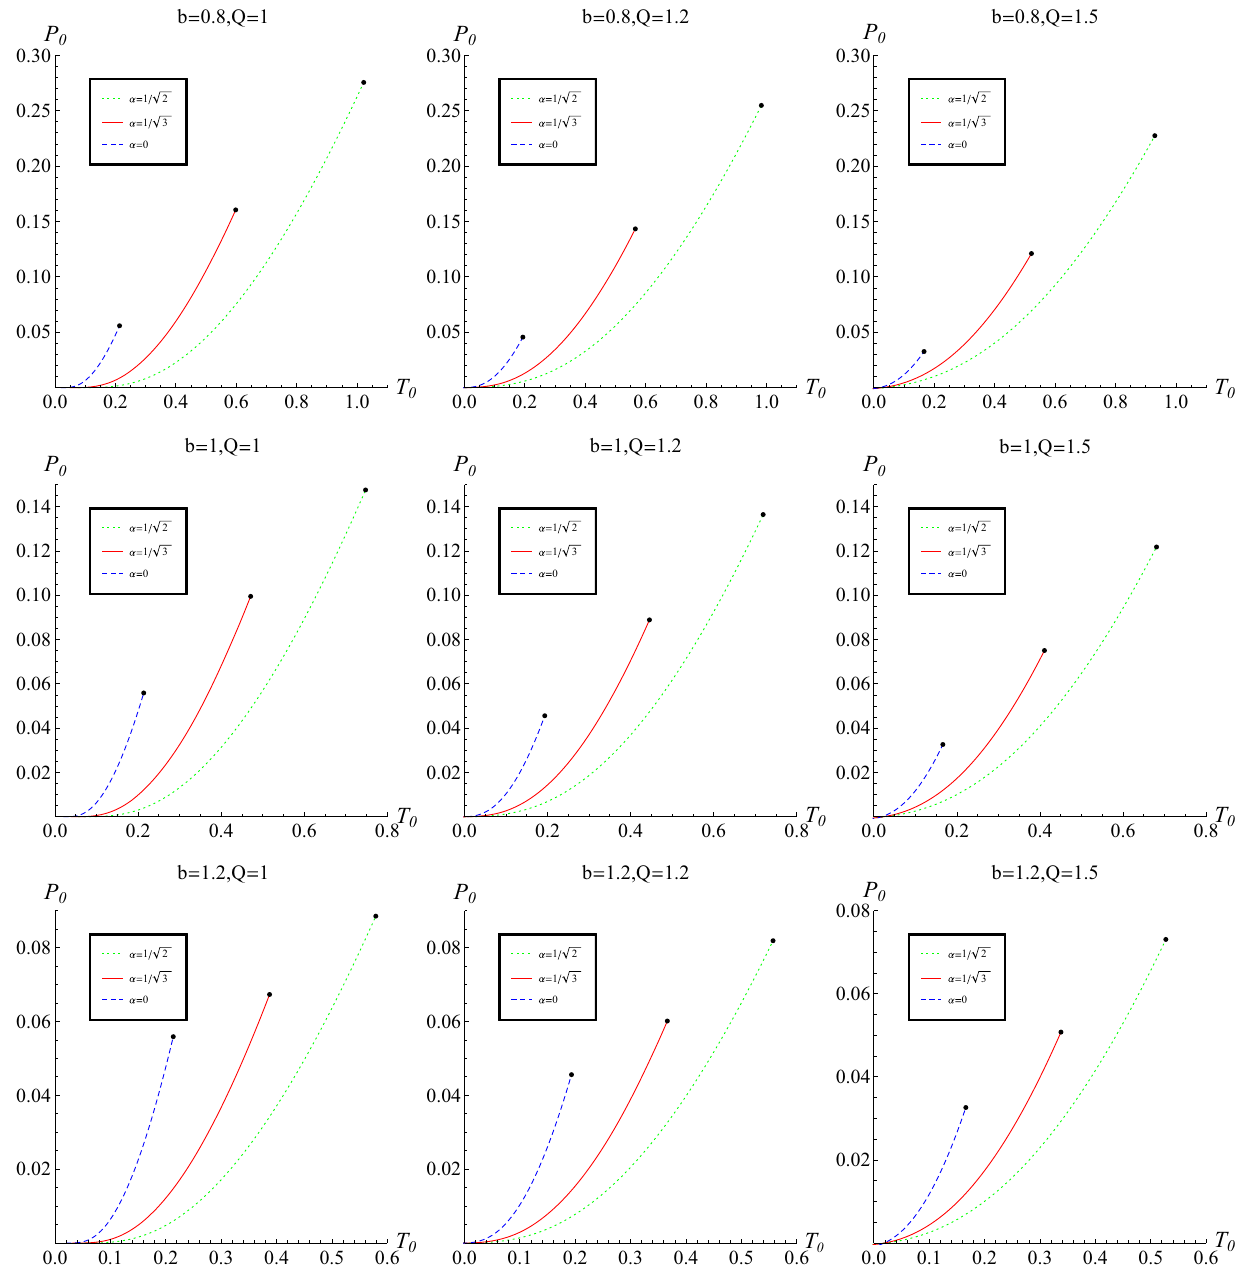
Fig. 3 Two-phase equilibrium coexistence curves in the P – T dia- grams for the topological dilaton black hole in 5-dimensional AdS spacetime. In the diagram, we have the first line with b = 0 . 8, the